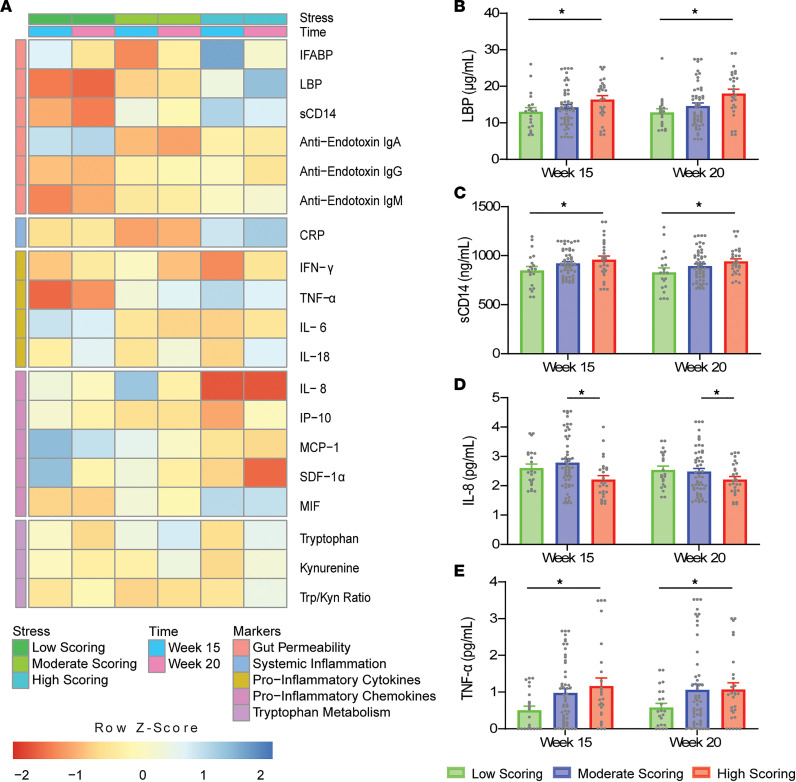
Differences in PSS-scoring groups across gestational time points in the healthy cohort (N = 22/54/28 from low/moderate/high).(A) Heatmap of normalized biomarker means across scoring groups and time points. Individual boxes are represented on a scale from red to blue. Darker red boxes represent markers whose concentrations were found to be at least 1 standard deviation lower than the mean concentration across stress group and time point. Darker blue boxes represent markers whose concentrations were found to be at least 1 standard deviation higher than the mean concentration across stress group and time point. Lower z scores are evident for lipopolysaccharide binding protein (LBP), soluble CD14 (sCD14), and TNF-α in the low-scoring group at 15 and 20 weeks; and for IL-8 in the high-scoring group at 15 and 20 weeks. Significant differences between PSS-scoring groups are illustrated for (B) LBP, (C) sCD14, (D) IL-8, and (E) TNF-α (2-way ANOVA with Tukey’s honestly significant differences test, HSD). *P < 0.05.